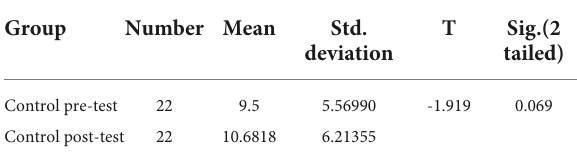
TABLE 6 Paired Samples t -test for the difference in the mean scores of (WDT) pre and post-test for the control